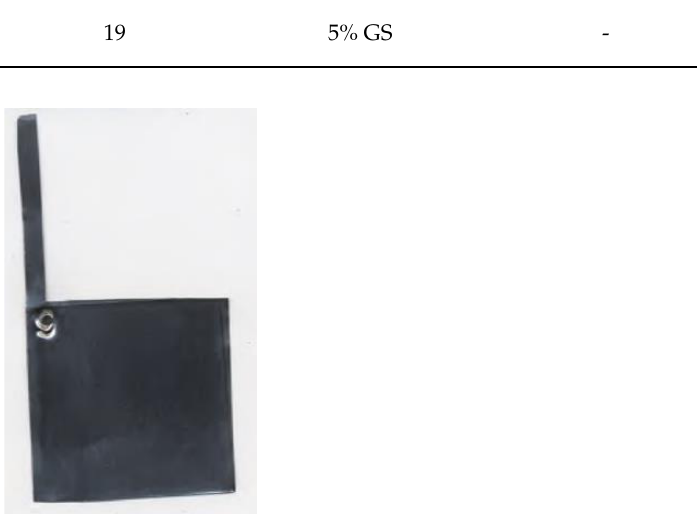
Figure 1. Photograph of a metal sample for electrochemical testing. Electrochemical measurements were carried out in a standard three-electrode cell using an IPC-Pro MF potentiostat (“Volta”, Saint Petersburg, Russia). After grinding with grade “0” sandpaper, the samples were additionally washed in a “Sapphire—0.8 TTs” ultrasonic bath in a C 2 H 5 OH:C 7 H 8 (1:1) mixture for 25 min. In order to eliminate the edge